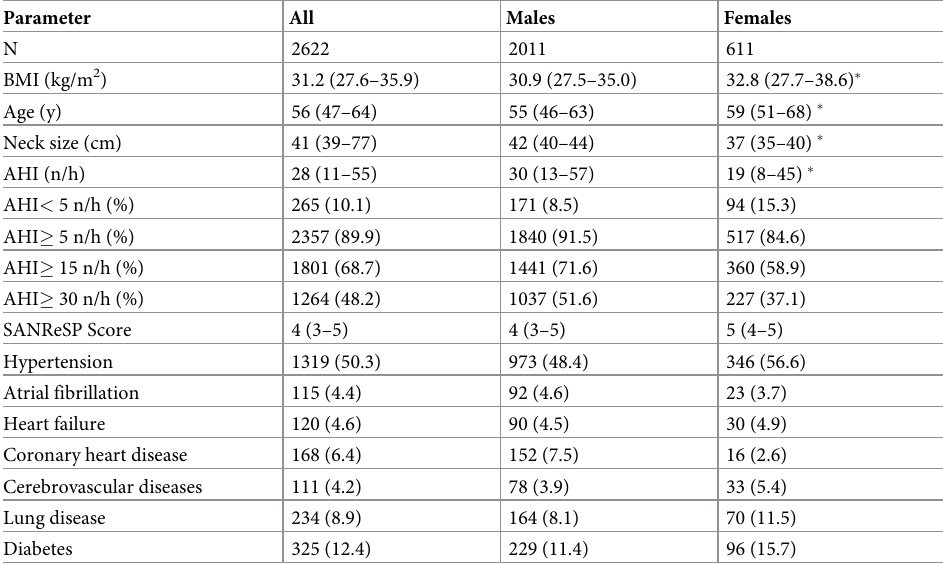
Lung disease Diabetes 325 (12.4) 229 (11.4) 96 (15.7) Data are presented as median (25% - 75% interquartile range) or number (percentage). BMI = body mass index; AHI = apnea-hypopnea index. Non-parametric Wilcoxon’s test was used to compared each variable of Males vs Females. � = p < 0.0001.